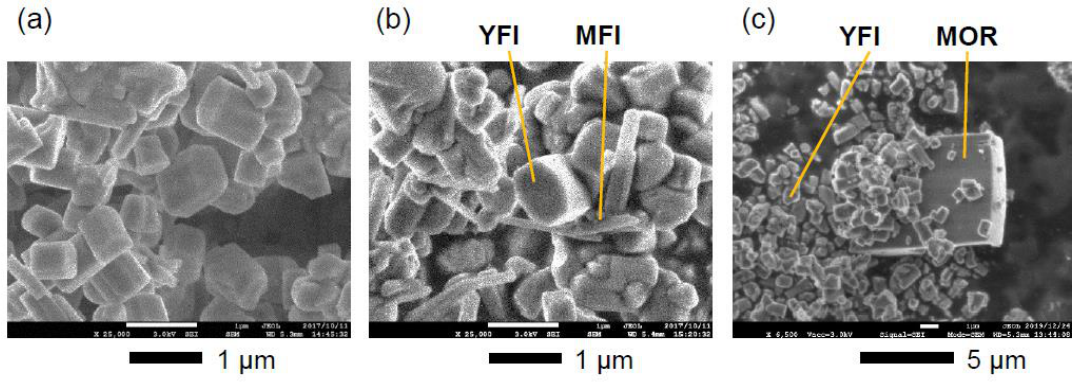
Figure 2. Field emission scanning electron microscopy (FESEM) images of the ( a ) pure YFI , ( b ) YFI with trace MFI , and ( c ) YFI with trace MOR .